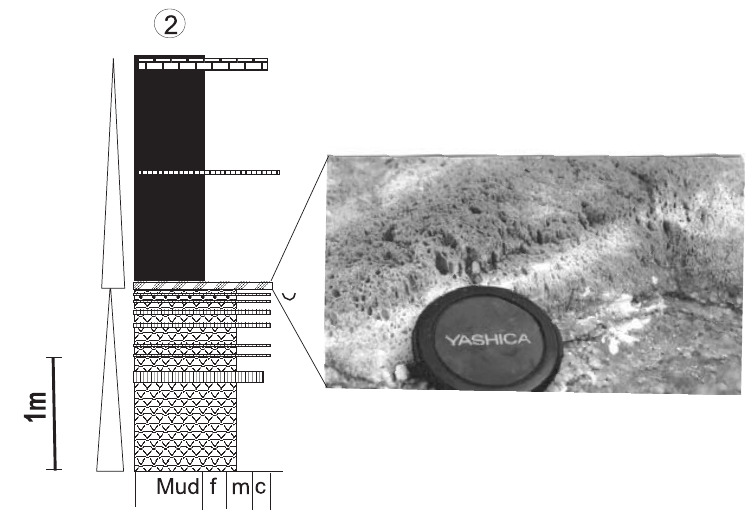
Fig. 6 –A lithostratigraphic profile illustrating the top of an evaporite succession marked by dissolution structures (pot holes) and tufa (see photograph). Note that evaporites are overlain by argillite deposits (laminated argillite-facies Al). (Lens cap for scale = 10 cm in diameter). (See figure 2 for legend).